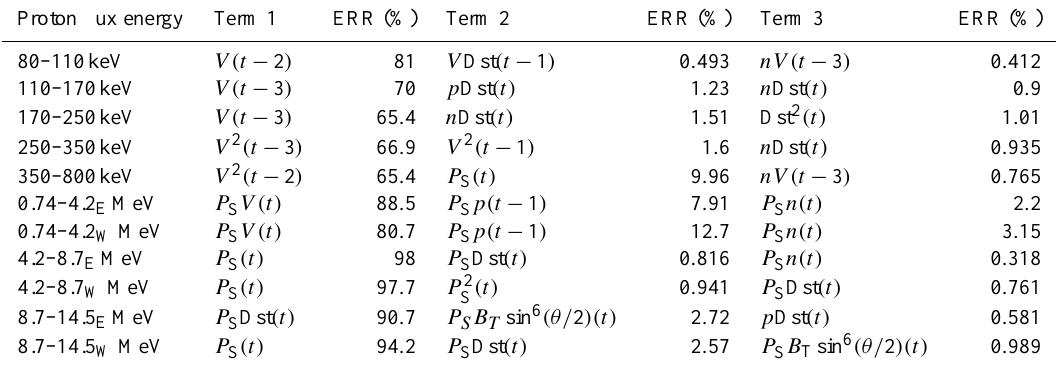
Table 1. Results of the ERR analysis. Shows top three terms with the